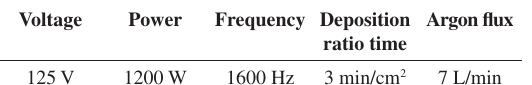
Table 2. Process parameters of ESD.